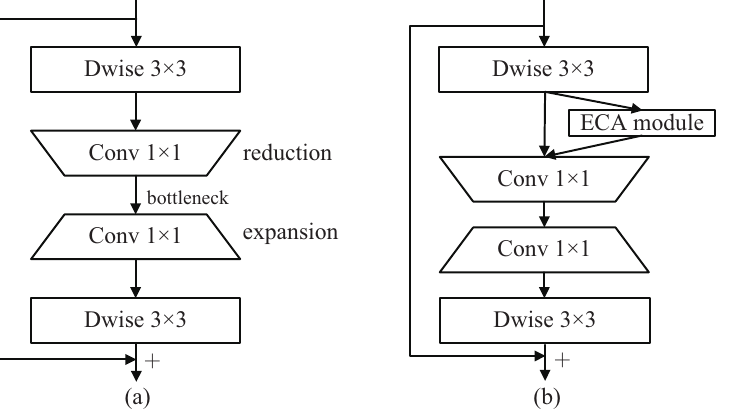
Figure 3. Schematic diagram of the bottleneck structure: ( a ) Sandglass Bottleneck ( b ) ESGBlock.